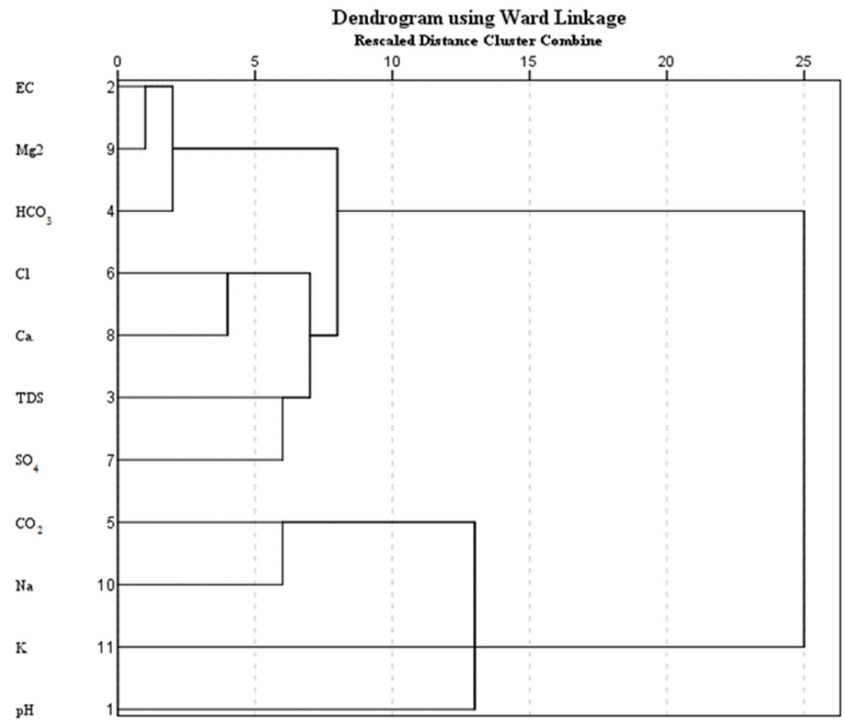
Figure 23. Cluster analysis (CA) for water physiochemical parameters for major